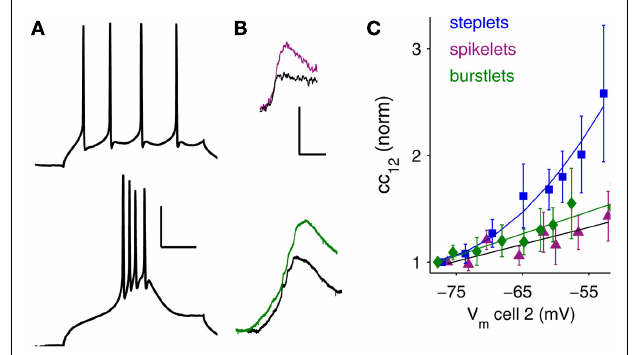
FIGURE 2 | Bursts, spikes, and amplification. (A) From hyperpolarized baseline voltages,TRN cells emit bursts (bottom; V m =− 77mV). At depolarized potentials,TRN cells spike regularly in tonic mode (top; V m =− 53mV). Scale bar is 25ms, 25mV. (B) The corresponding postsynaptic signals at electrical synapses: spikelets (top), and burstlets (bottom), for these different spiking modes are also amplified by membrane voltage; colored traces are at depolarized potentials (spikelet V m =− 50mV, burstlet V m =− 61mV) and black traces are at hyperpolarized potentials (spikelet V m =− 71mV burstlet V m =− 76mV. Scale bar is 5ms, 1mV (spikelets); 4mV, 50ms (burstlets). (C) Summary of scaling for steplets, spikelets, and burstlets measured in N = 12 pairs of neurons, plotted against baseline voltage in the receiving cell. Data are normalized to the most-hyperpolarized